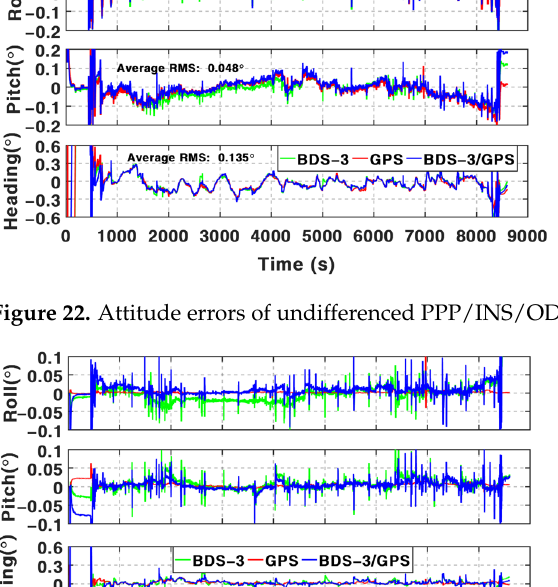
18 of 22 Figure 20. Attitude errors of BSSD PPP/INS TCI ( left ) and BSSD PPP/INS/ODO TCI ( right ) with frequent GNSS outages in the periods between the 1500 s and 2500 s. Figure 21. Average of Maximum attitude drifts of different GNSS for BSSD PPP/INS TCI ( left ) and PPP/INS/ODO TCI ( right ) on different GNSS outage scenes. Similarly, the differences between the attitudes calculated by the undifferenced PPP- based integration (Figure 22) and the BSSD PPP-based integration are plotted in Figure 23. The attitudes RMSs based on undifferenced PPP are 0.031 ° , 0.048 ° , and 0.135 ° in three components, which are close to the solutions based on BSSD PPP. As the result shows, the